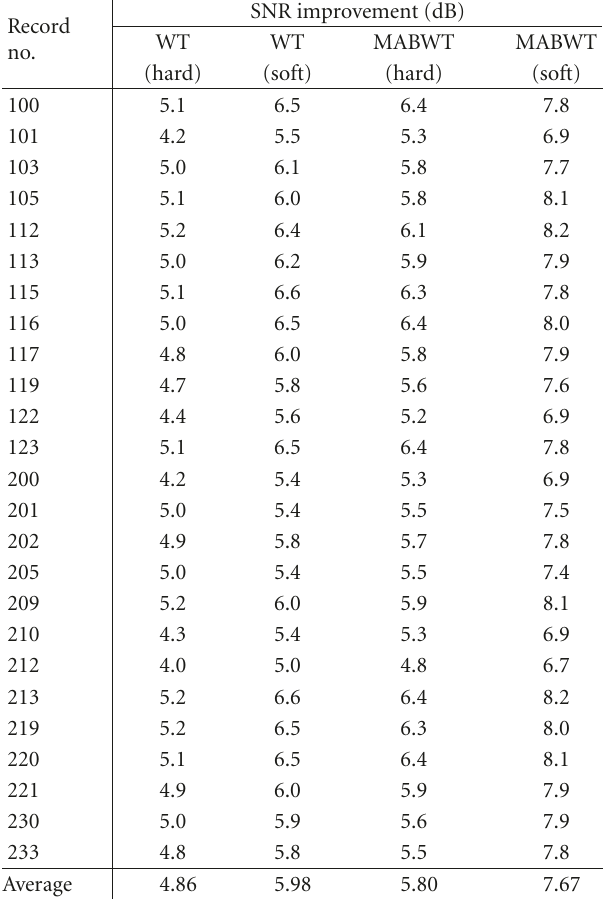
Table 1: WT and MABWT denoising performance on the MIT-BIH arrythmia